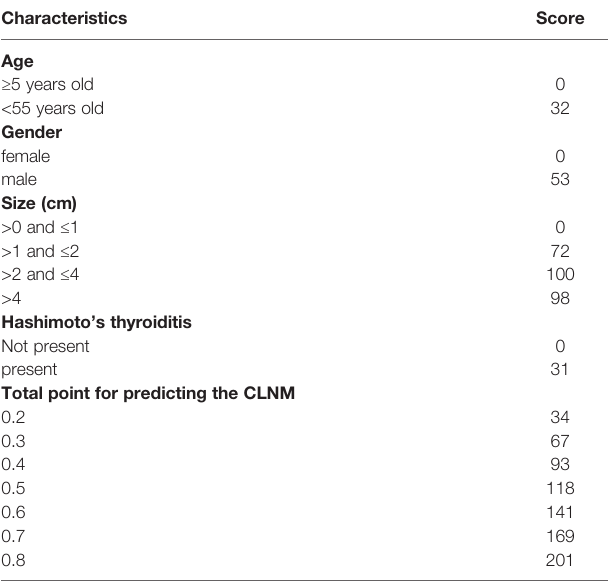
TABLE 4 | The speci fi c value of clinicopathological features in the nomogram. Characteristics